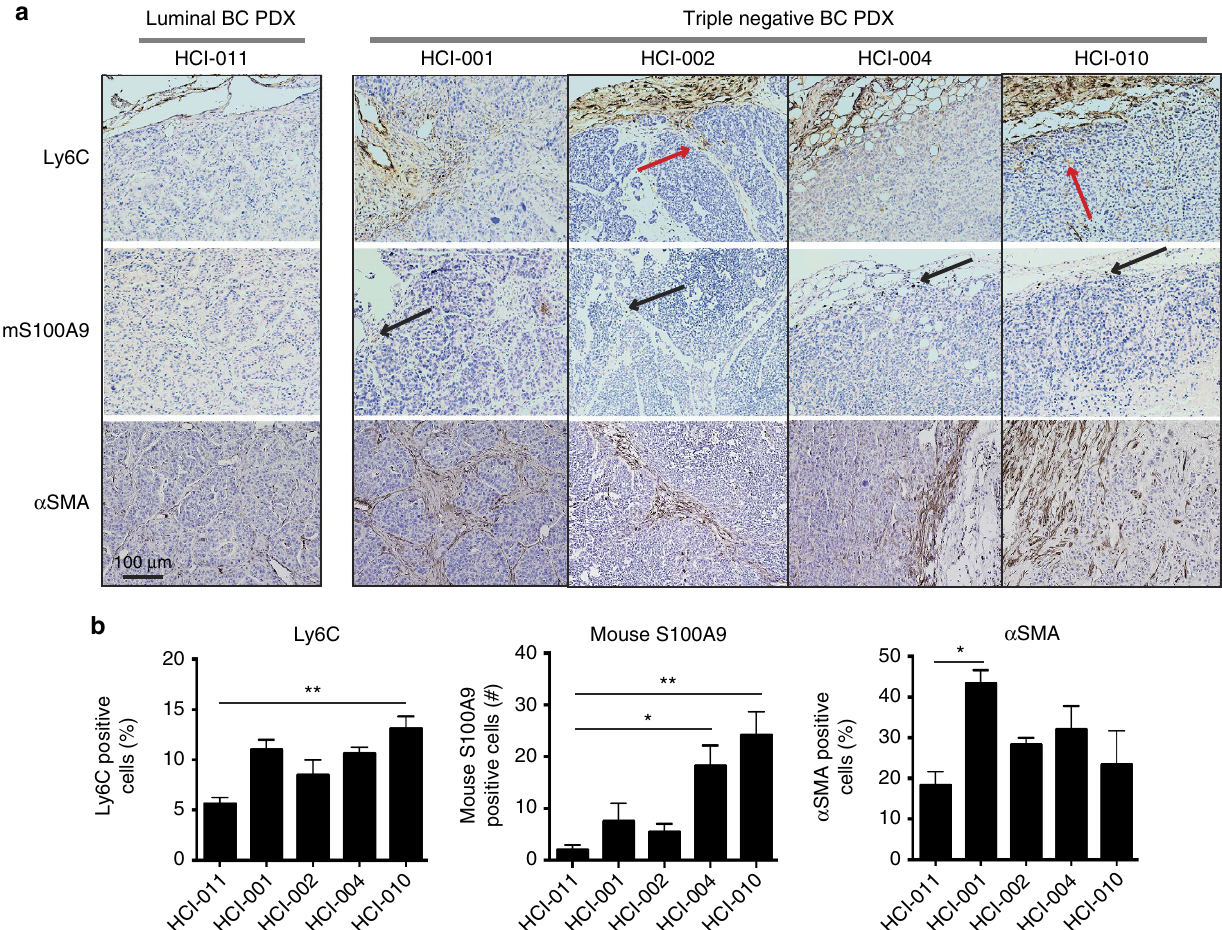
Figure 4 | IHC of PDXs. PDXs from TN breast tumours show increased myeloid cell infiltration, expression of S100A9 and activated fibroblasts. PDXs from one luminal (HCI-011) and four TN (HCI-001, HCI-002, HCI-004 and HCI-010) breast cancers grown in non-obese diabetic-severe combined